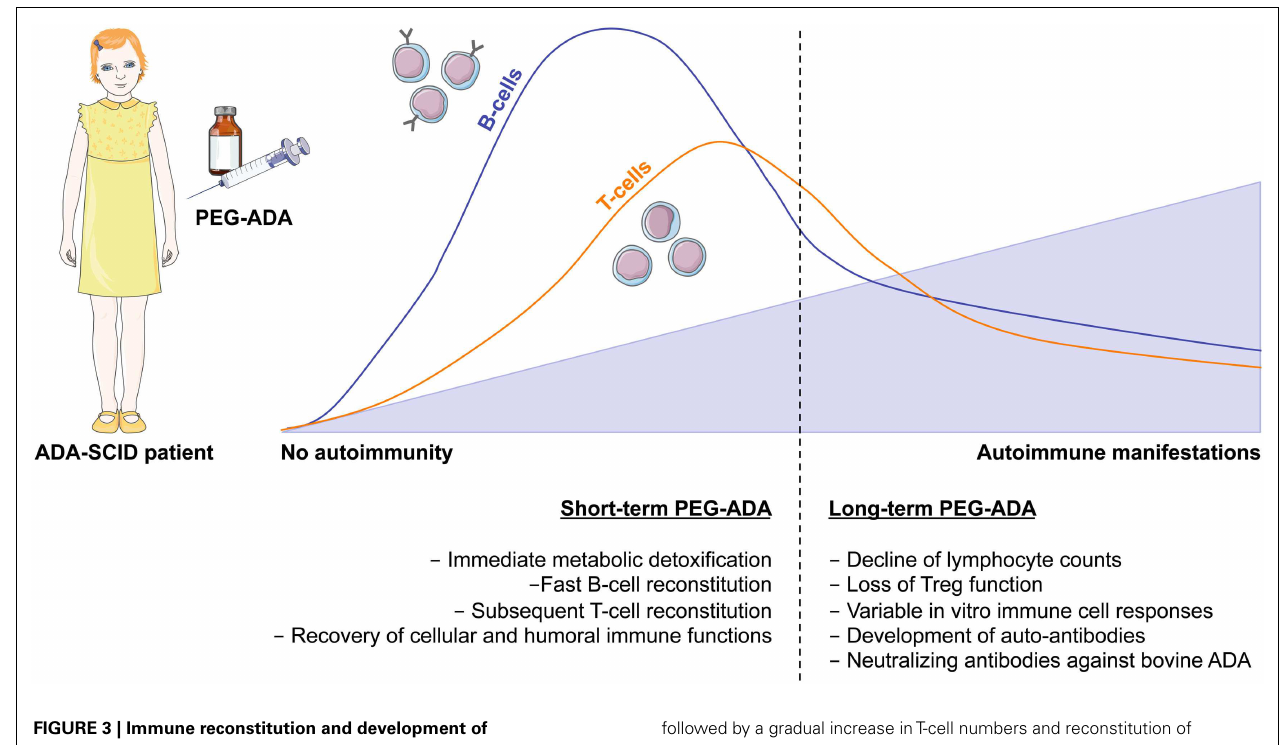
FIGURE 3 | Immune reconstitution and development of autoimmunity after PEG-ADA treatment. Enzyme replacement therapy with pegylated bovine ADA is a lifesaving but non-curative treatment for ADA-SCID patients. It provides metabolic detoxification and protective immune function with patients remaining clinically well, but immune reconstitution is often suboptimal and may not be long-lived. Shortly after initiation of PEG-ADA treatment, patients show recovery of B-cell counts,